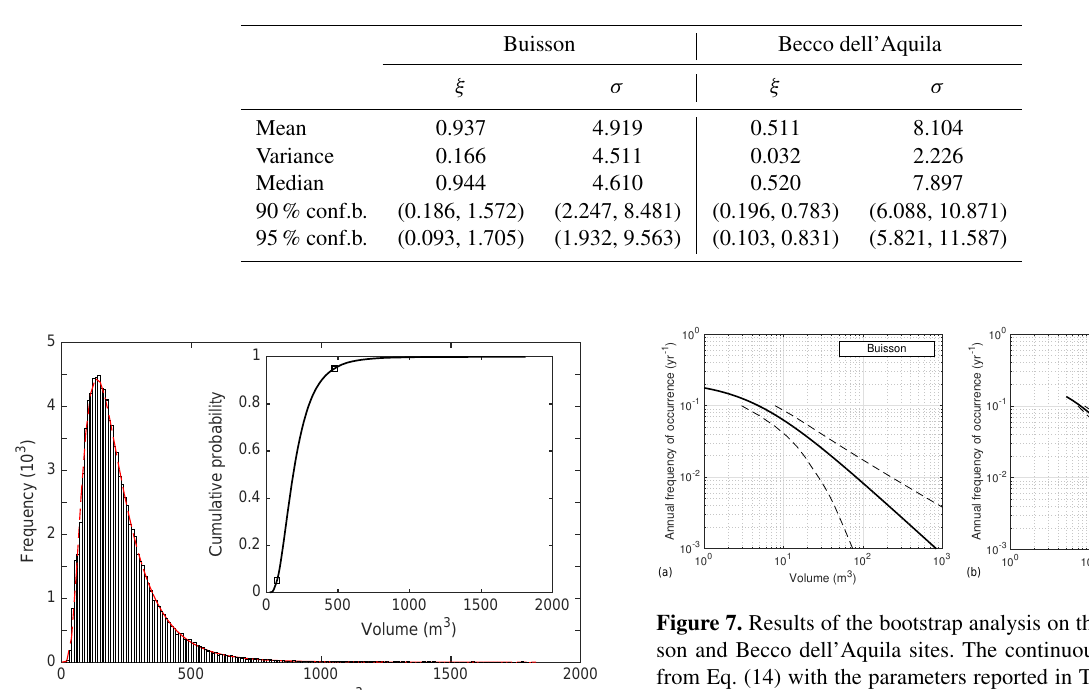
Table 5. Bootstrap statistical parameters of the estimates of the parameters of the generalized Pareto distribution related to the two example sites.